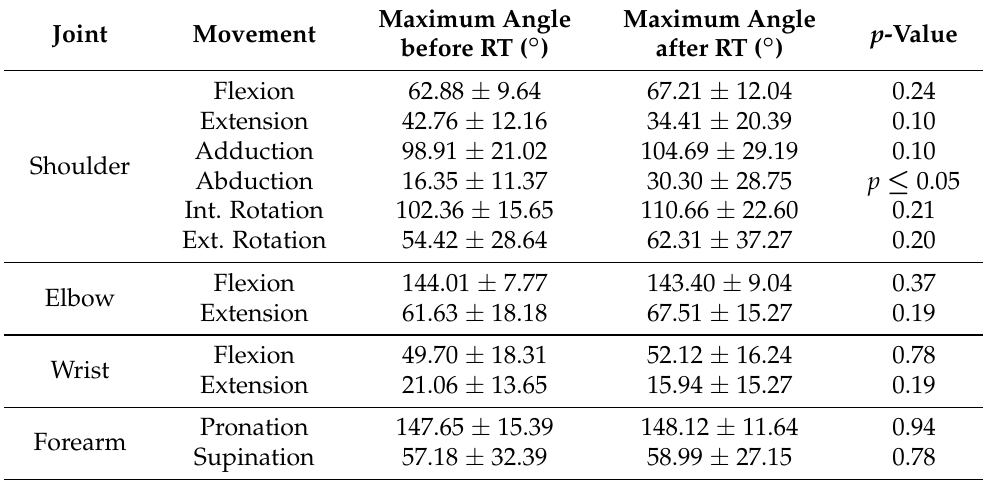
Table 9. Maximum angles obtained for the paretic limb in the Apley Scratching Test before and after the rehabilitation therapy.